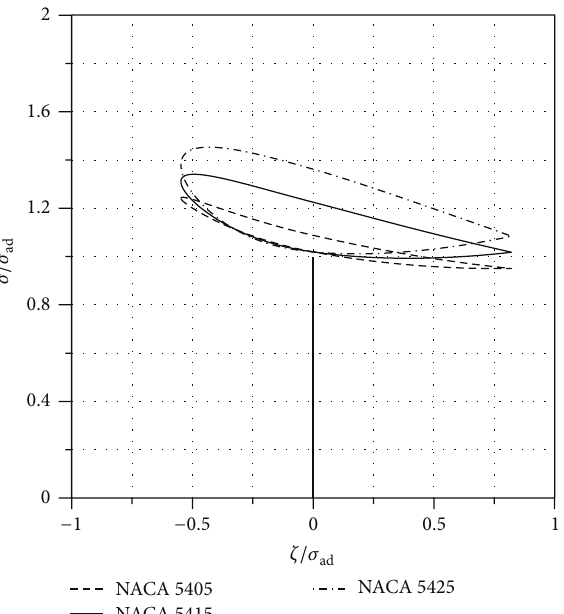
Figure 2: Profiles employed to investigate the effects of the duct cross section camber. Table 1: Geometrical details of the reference profile. Ratio between the tip gap and 𝜎 ad ∼ 2% Ratio between the chord and 𝜎 ad 1.4 Angle between the chord and the 𝜁 axis 12.0 ∘